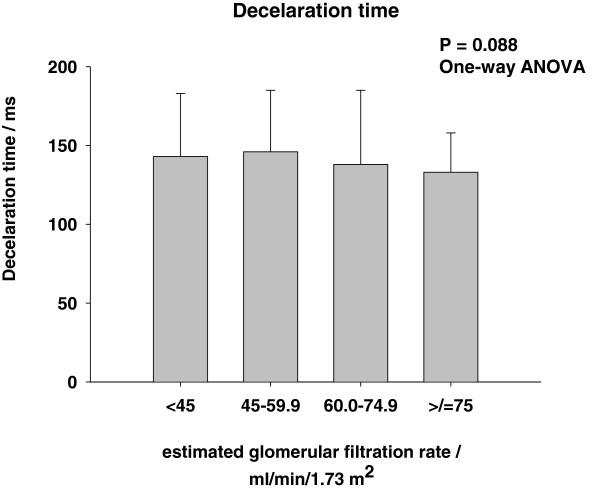
Deceleration time.